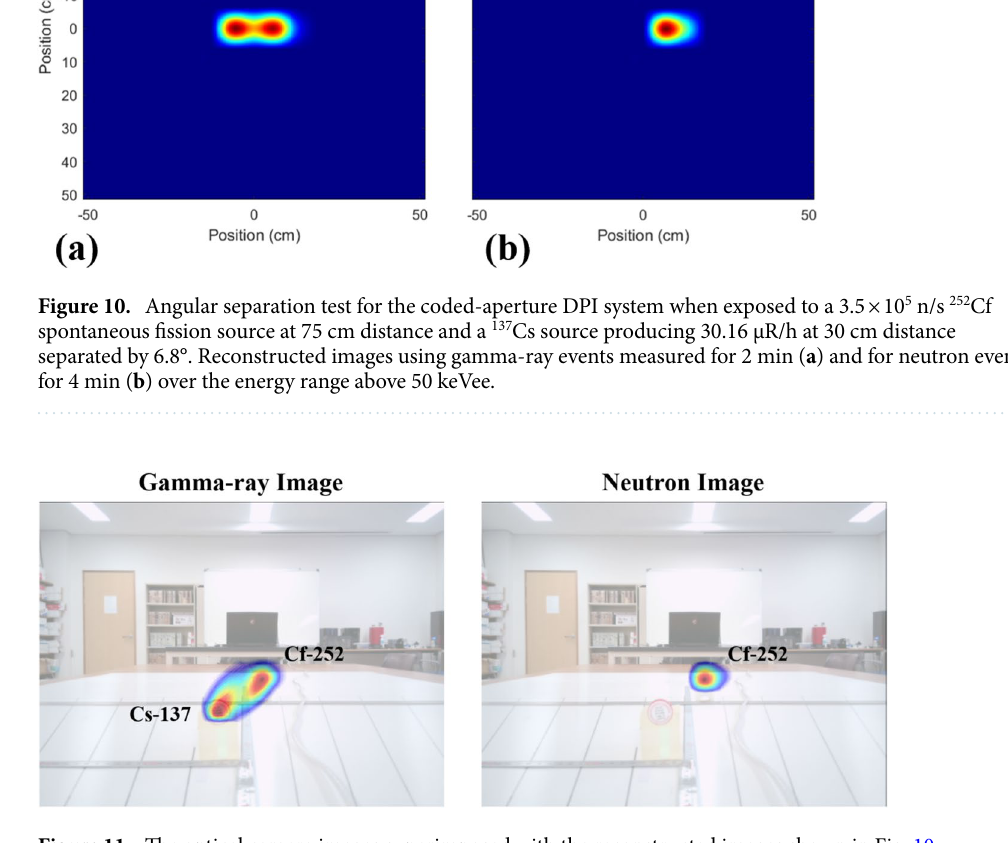
Figure 11. The optical camera images superimposed with the reconstructed images shown in Fig.